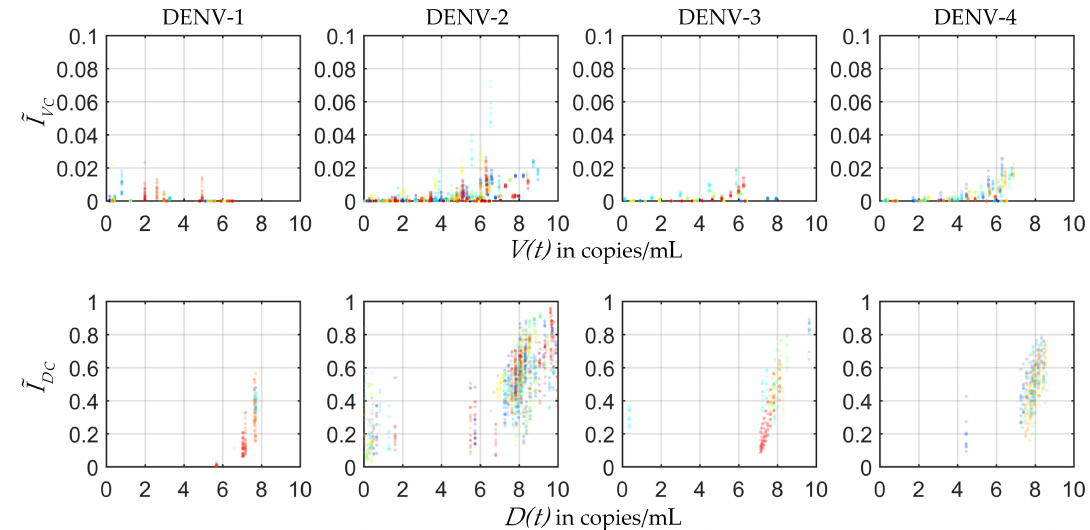
Figure 6. Controlled MIDs: Scatter plots show the controlled infected fractions ( I VC and I DC ) of the mosquito population versus the controlled patient viraemias ( V ( t ) and D ( t ) ). The transmission of DI particles with respect to the Log 10 values of the plasma DI particles ( D ( t ) ) has notable rise after applying the control (see Figure